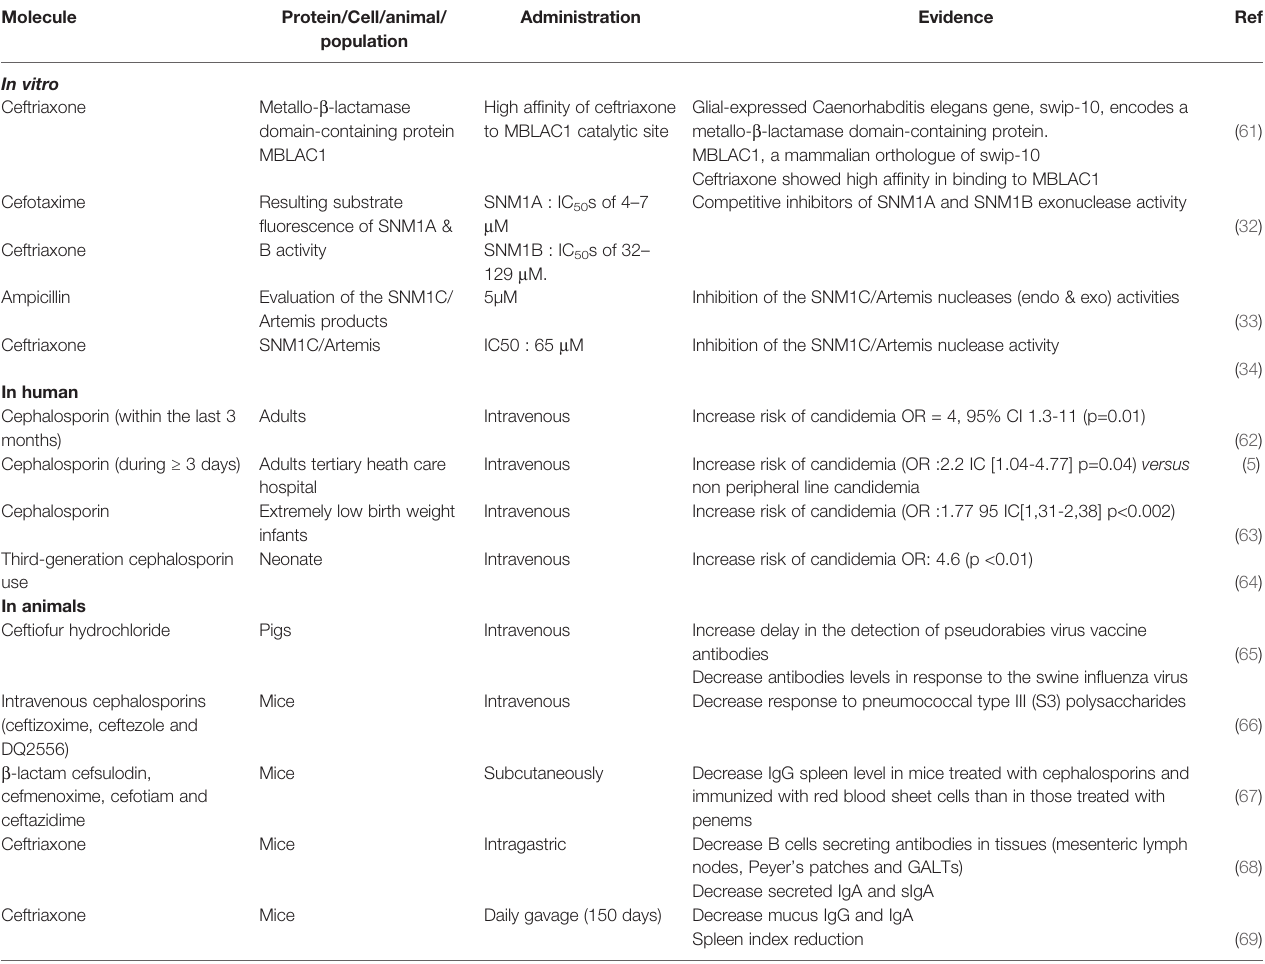
TABLE 3 | Evidences of the impact of b -lactam antibiotics on SNM1C/Artemis: in vitro and in vivo evidences of a decrease in the immune response especially the humoral response.